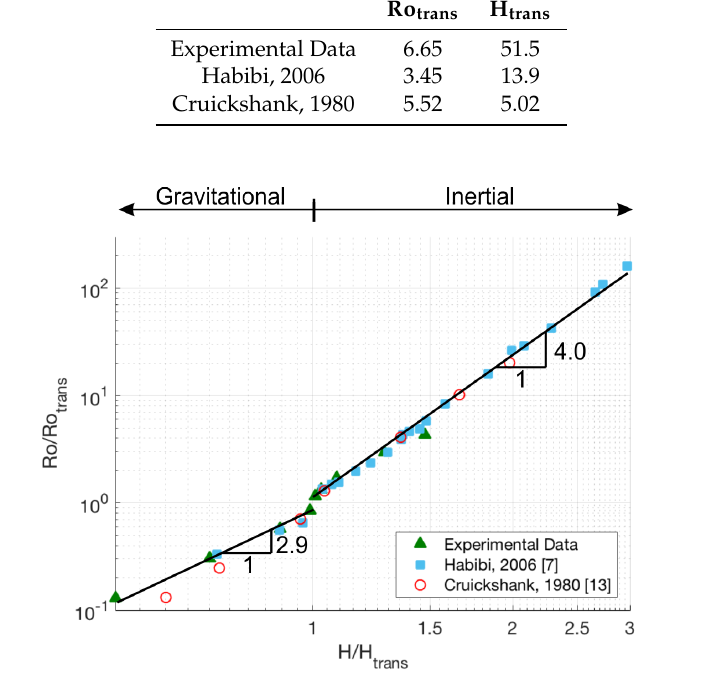
Figure 11. Roshko numbers and non-dimensional heights of the experimental data collected here and those reported by Habibi [7] and Cruickshank